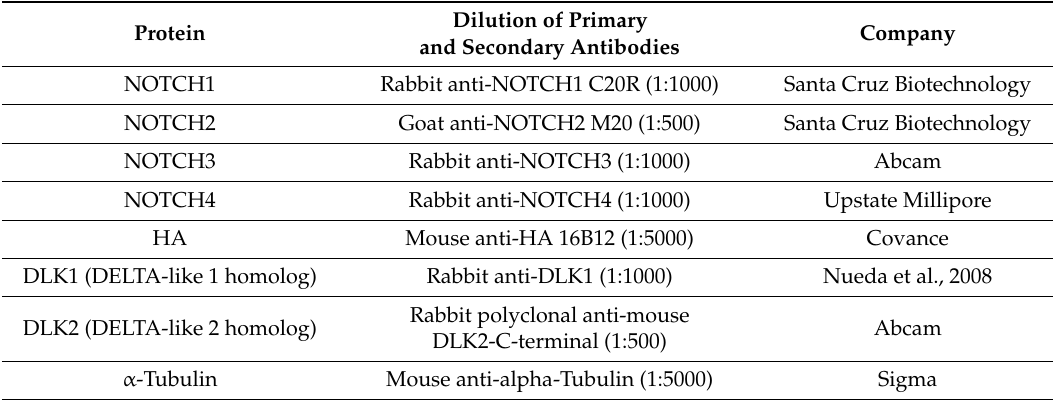
Table 1. Primary and secondary antibodies used in Western blot analysis. Dilution of Primary Protein and Secondary